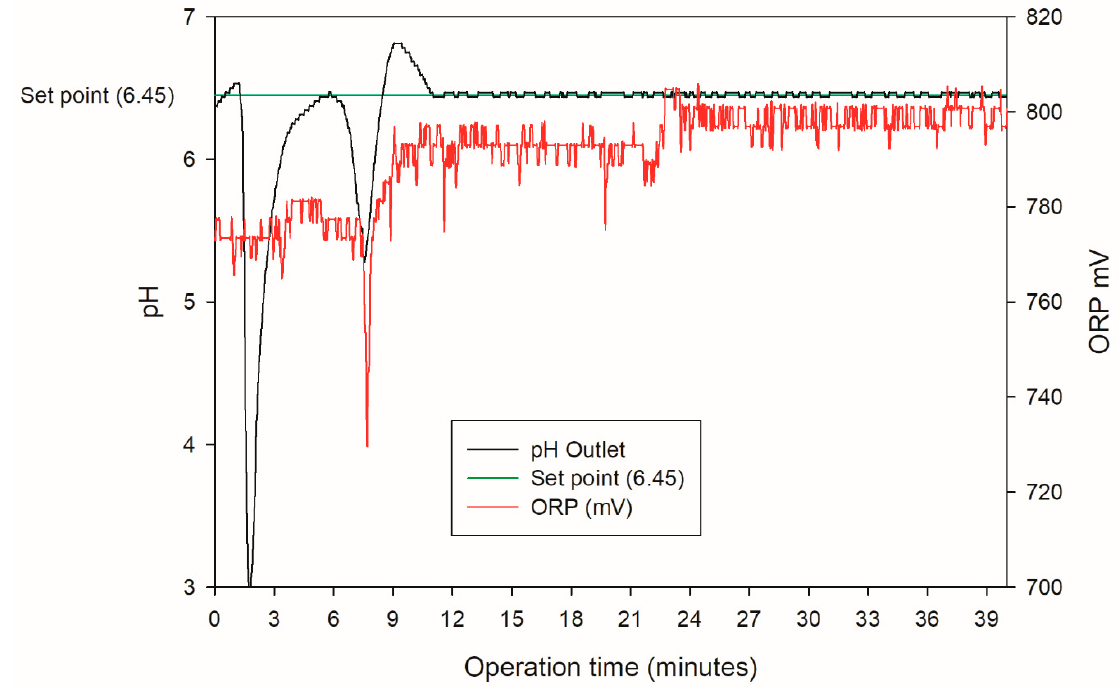
Figure 2. pH and ORP values obtained from the water treatment plant prototype.